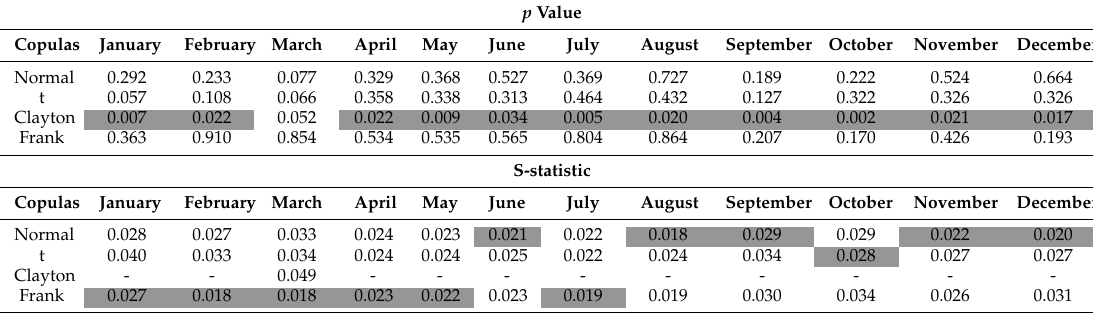
Table 5. p value and S-statistic leaving the third year out in cross-validation for the BNFO model. p